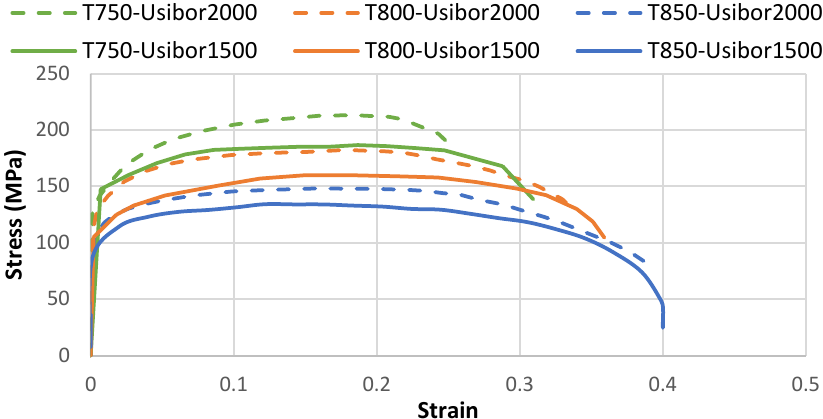
Figure 9. Stress – strain curves of the two investigated UHSS at a strain rate of 0.1 s − 1 for each test temperature investigated.